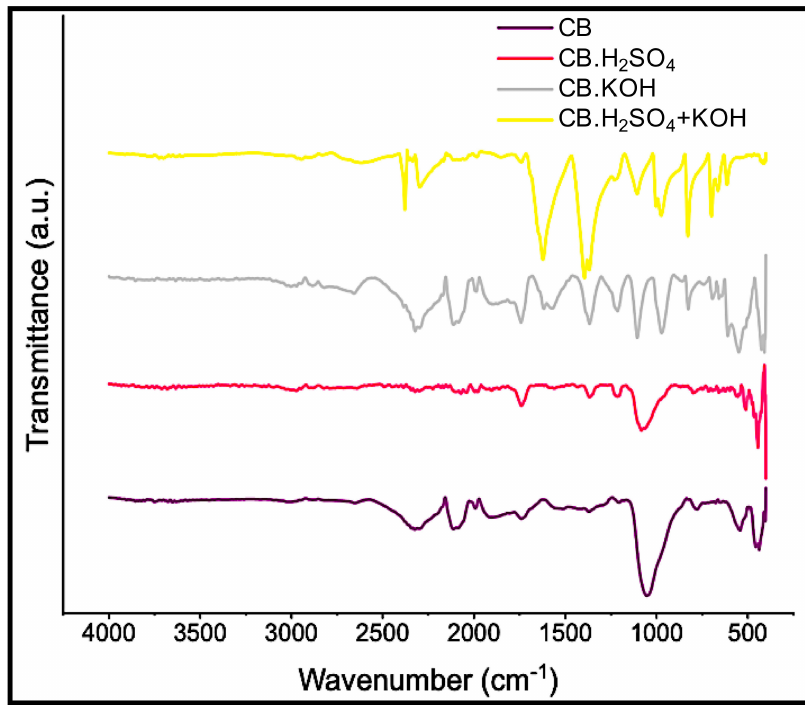
Figure 4. Fourier transform infrared (FTIR) spectra of carbon black